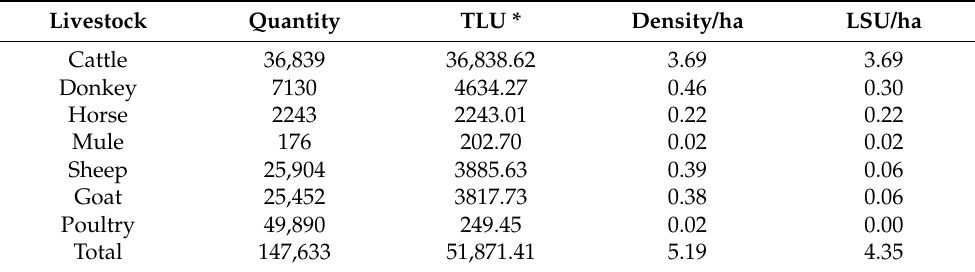
Table 10. Livestock density in Matenchose